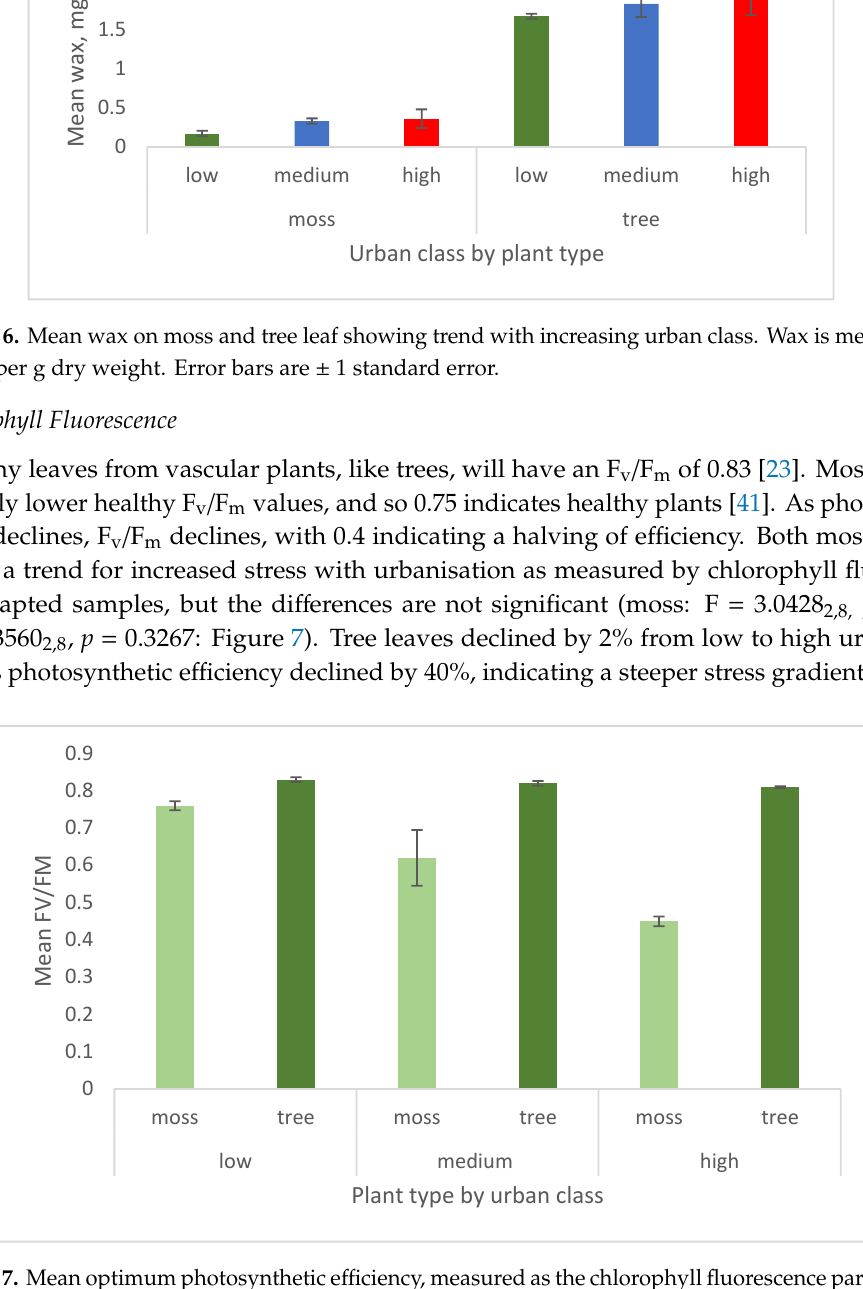
Figure 7. Mean optimum photosynthetic efficiency, measured as the chlorophyll fluorescence parameter F v /F m after dark adaptation in the laboratory. Each urban class is an average of F v /F m over nine sites. Error bars are + 1 standard error.